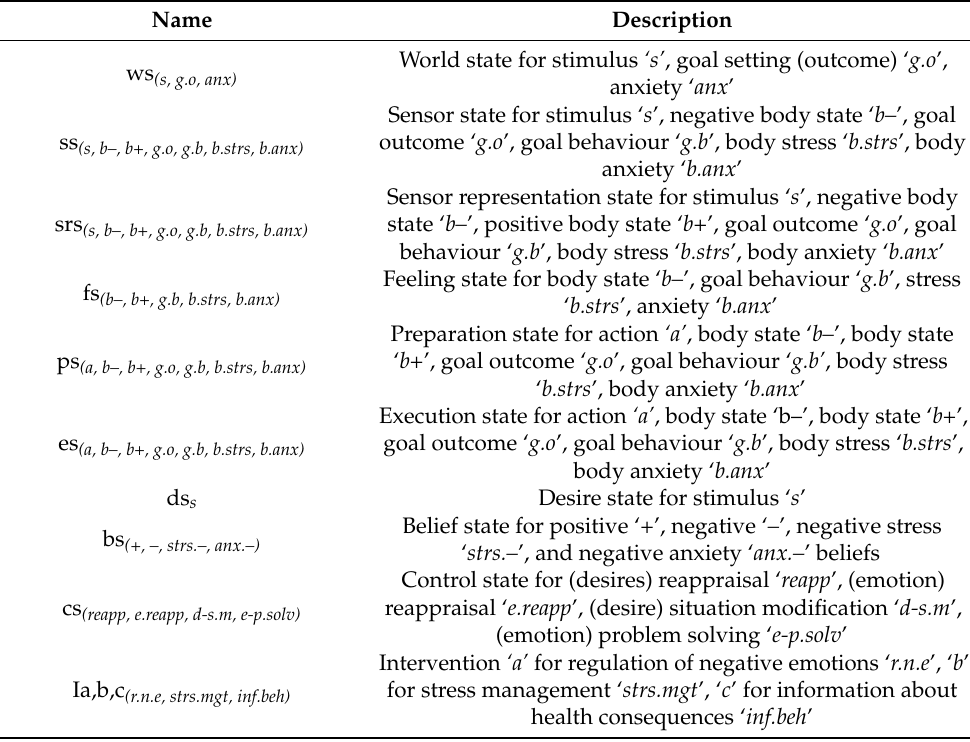
Table 3. Nomenclature of the states used in the